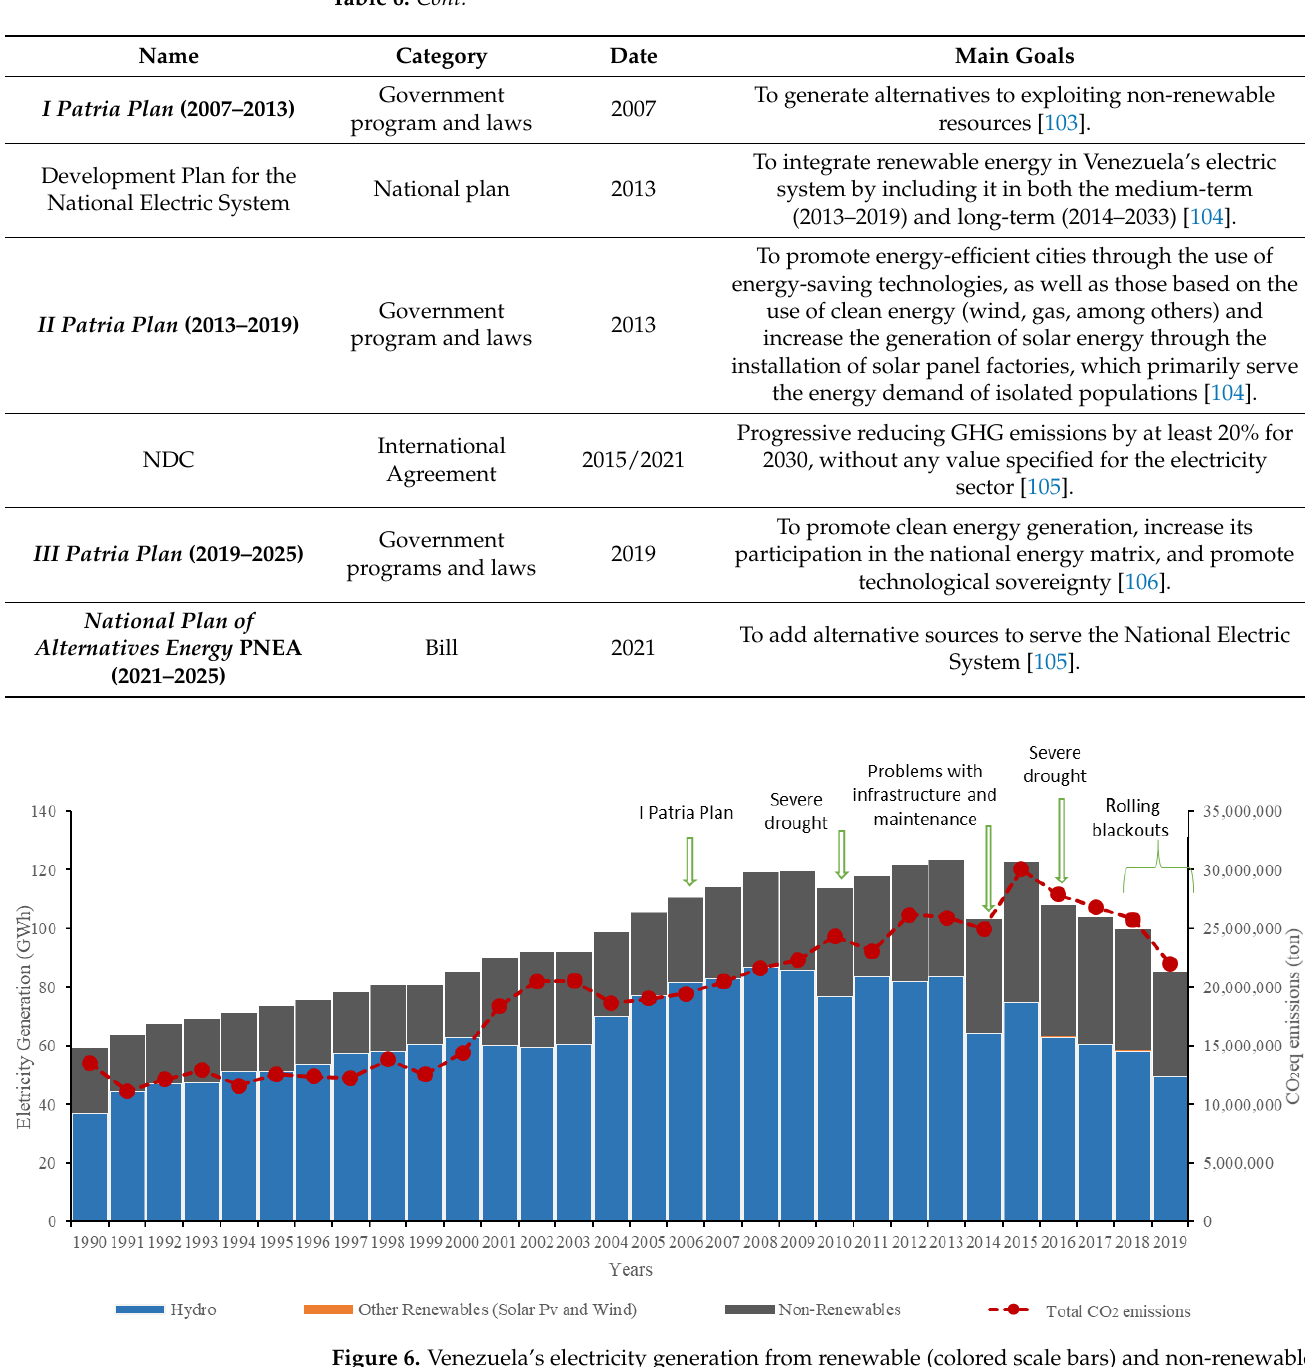
Figure 6. Venezuela’s electricity generation from renewable (colored scale bars) and non-renewable (grayscale bars) and the total CO 2 eq emissions. Source: Elaborated by the authors based on [38 – 40].